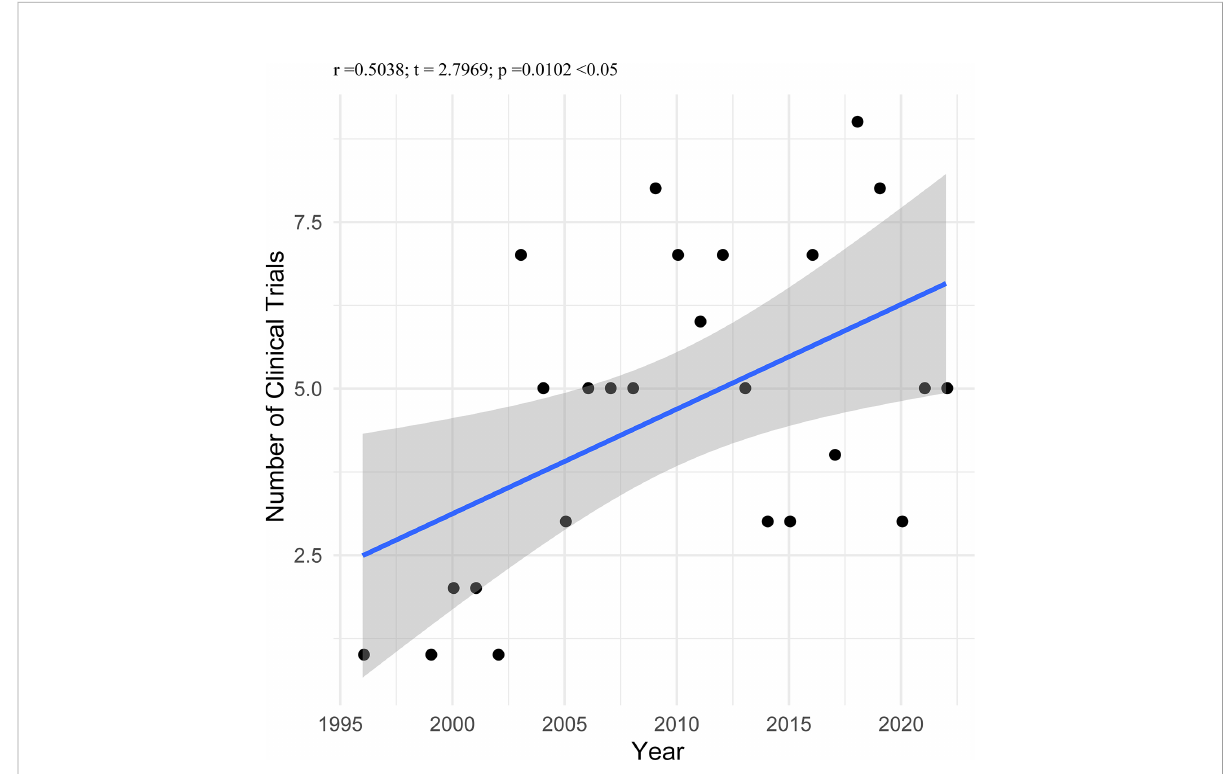
FIGURE 2 Correlation between the number of trials and beginning year in the 117 included